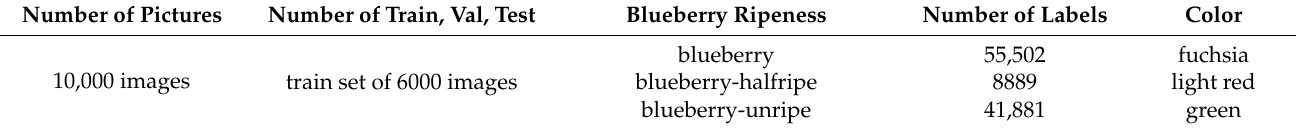
Table 1. Dataset partition.